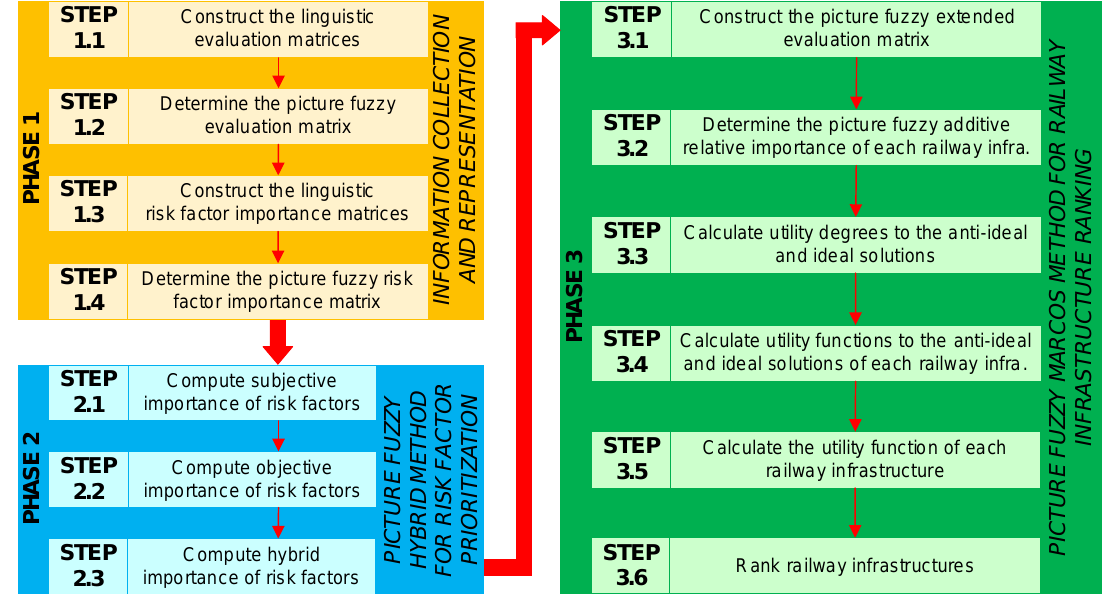
Figure 1. The flowchart of the picture fuzzy group MCDM approach for risk assessment of railway infrastructure.